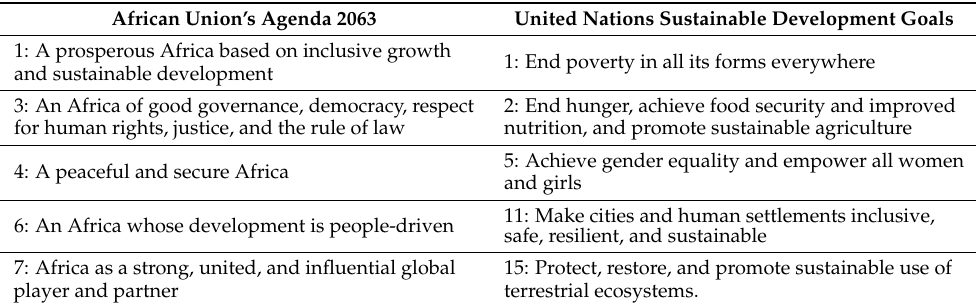
Table 1. Aspirations of the African Union and SDGs that align with FFP